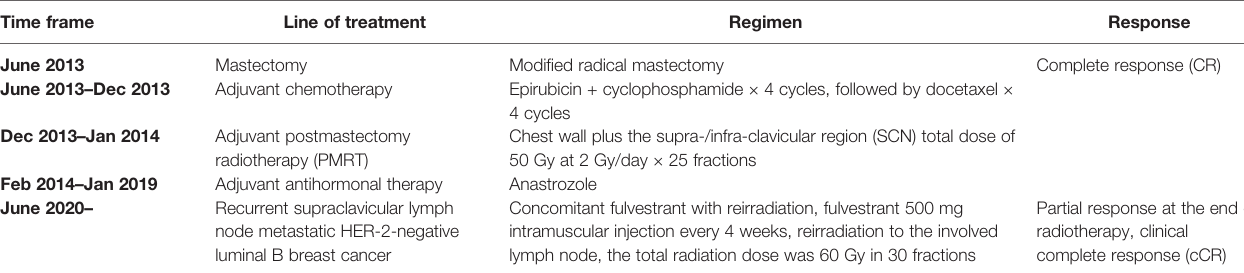
TABLE 3 | The brief course of disease in the patient diagnosed with breast cancer. Time